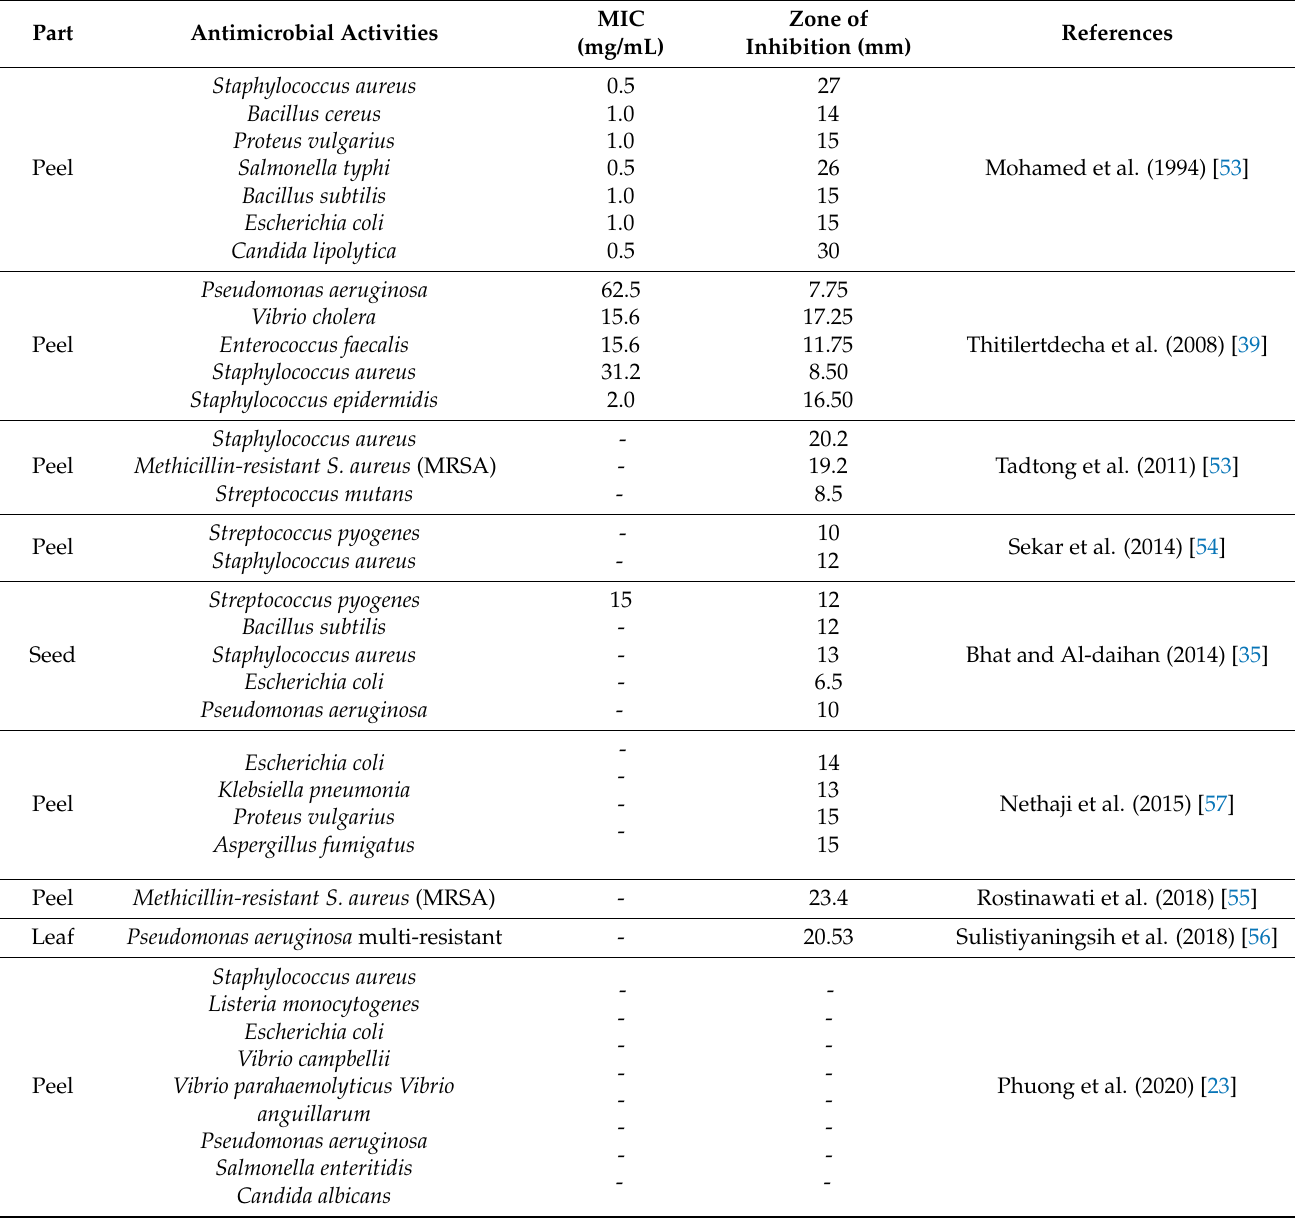
Table 5. List of anti-microbial tests performed on N. lappaceum